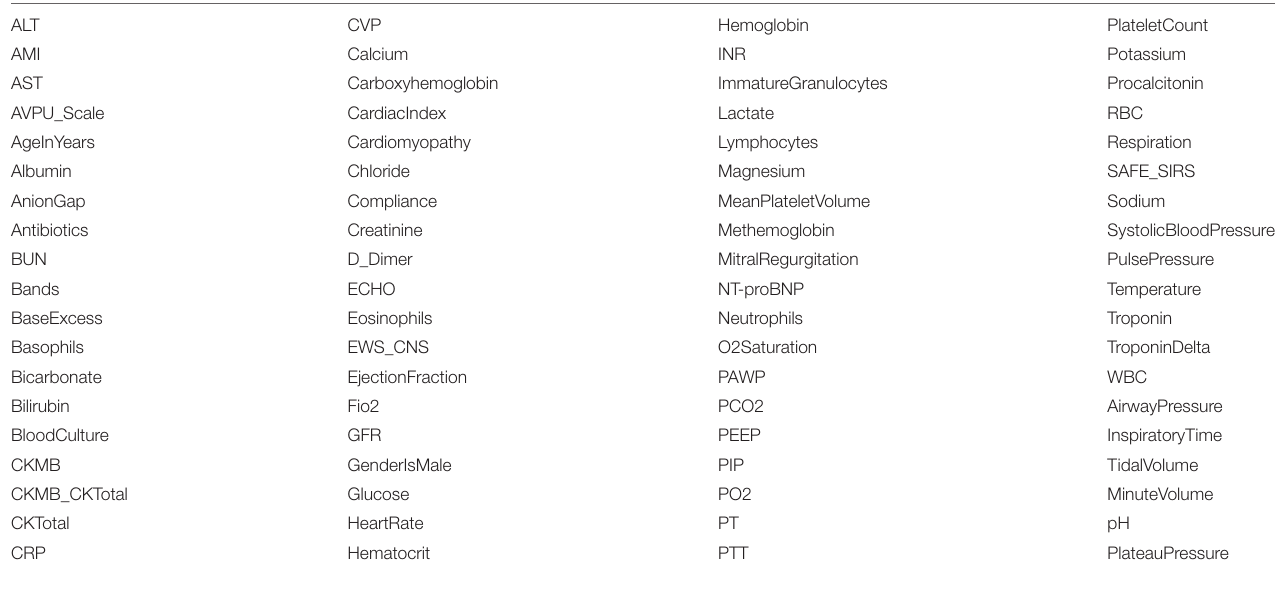
TABLE 5 | Input variables extracted for mode training.